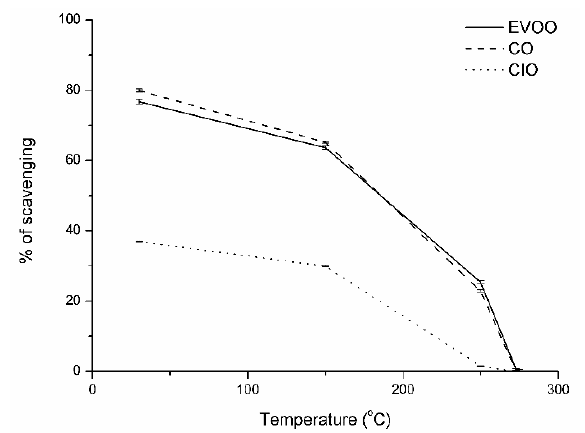
Figure 4. Total phenolic content of Colliguaya integerrima (CIO), Cynara cardunculus (CO) and extra-virgin olive (EVOO) oils at each studied temperature.